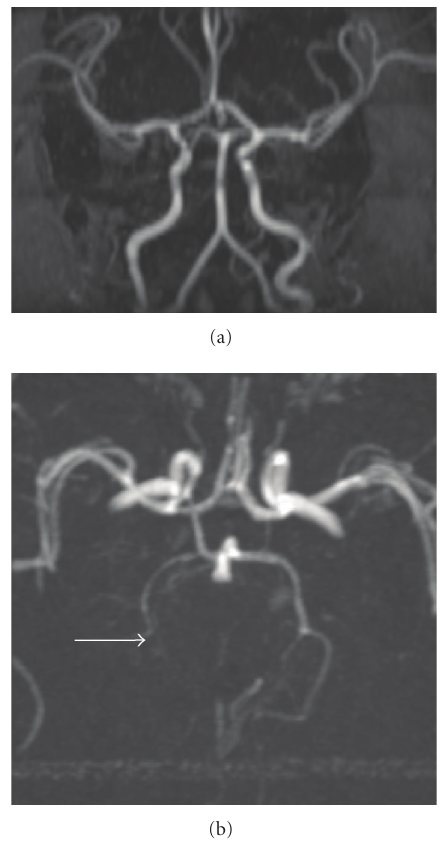
Figure 3: 3D MIP images from a noncontrast 2D time of flight MRA demonstrate restoration of flow in the right internal carotid artery and posterior circulation. Residual occlusion of the distal right PCA persists